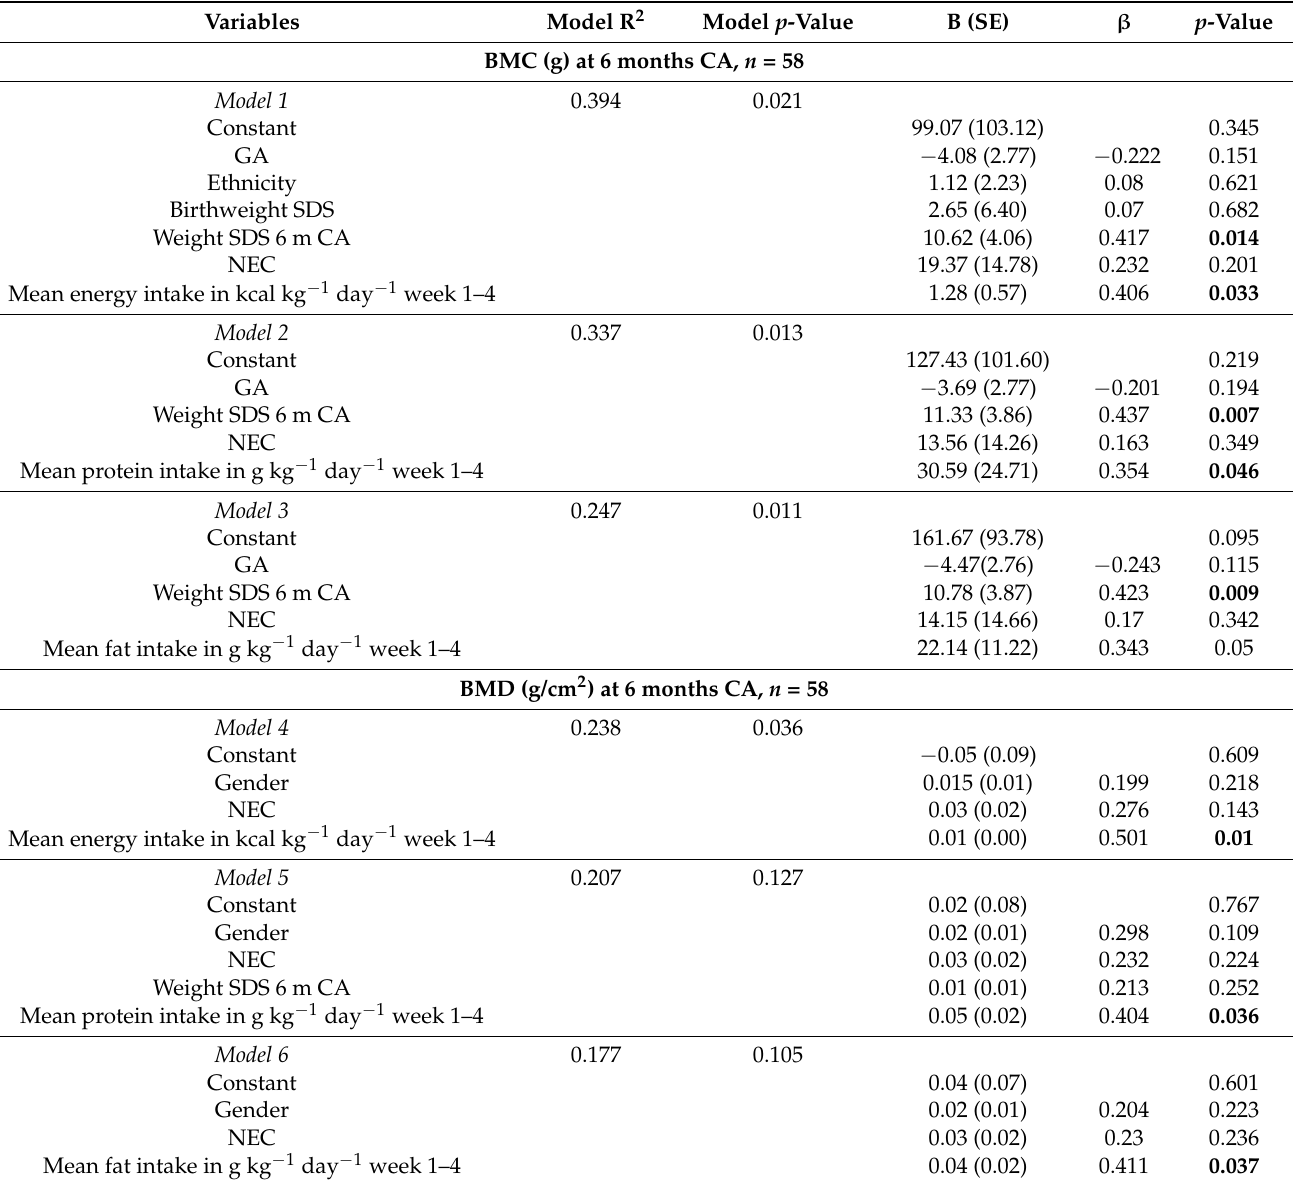
Table 6. Regression analyses of mean intake in the first four postnatal weeks as a predictor for BMC and BMD at six months